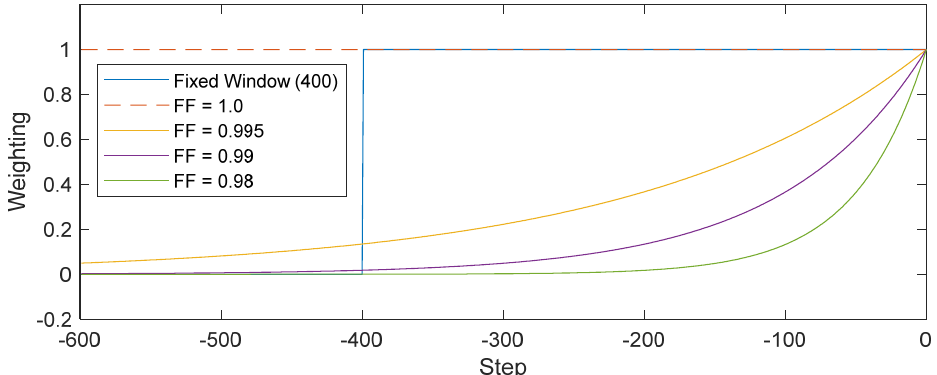
Figure 1. The weighting of various forgetting factors and fixed window.